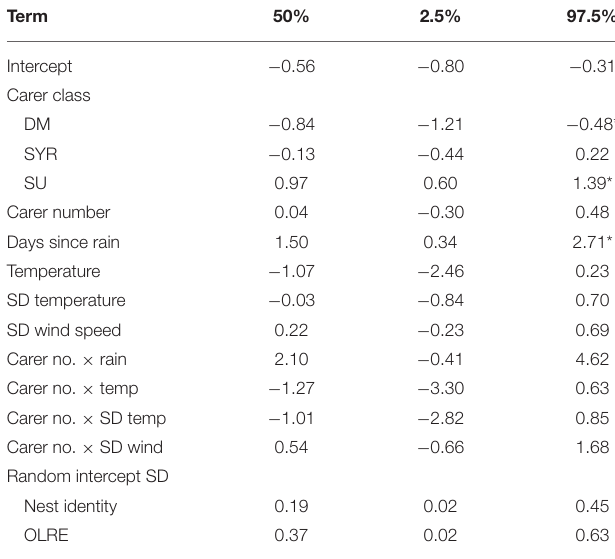
TABLE 3 | Phenological, meteorological, and social effects on the coefficient of variation in daily provisioning rates across days within nesting attempts as a function of carer